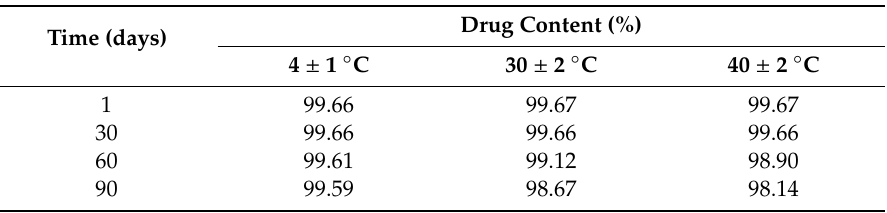
Table 2. Chemical stability studies of APR-ME.